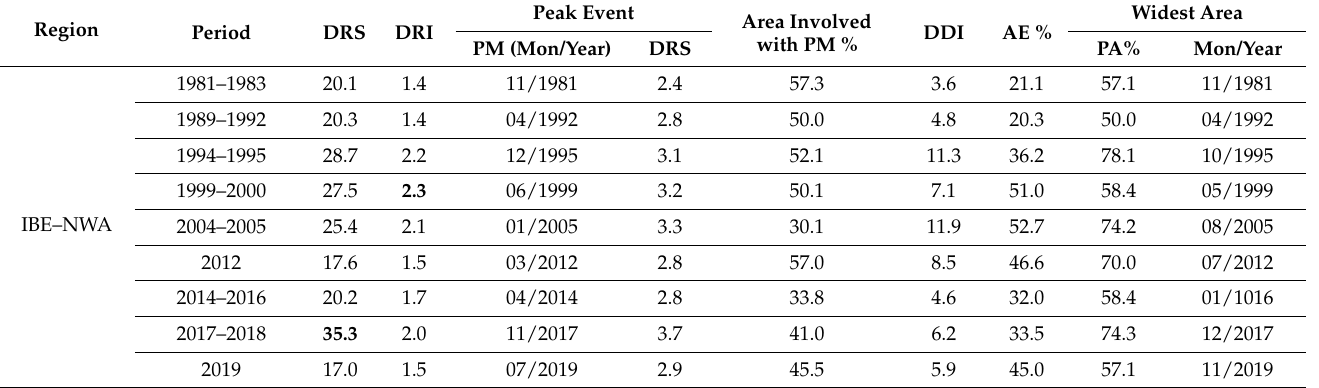
Table 4. List of the widest drought events detected by the DXI-12 and their corresponding areal extent, the area involved by the peak month, and the Degree of Dryness (DII) of widest area at the subregional scale during 1975–2019. Peak Event Area Involved Region Period DRS DRI with PM %